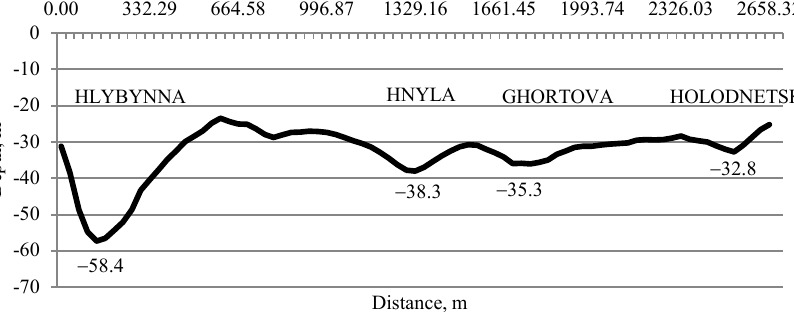
Fig. 10. Depth profile within the rift of Svitiaz